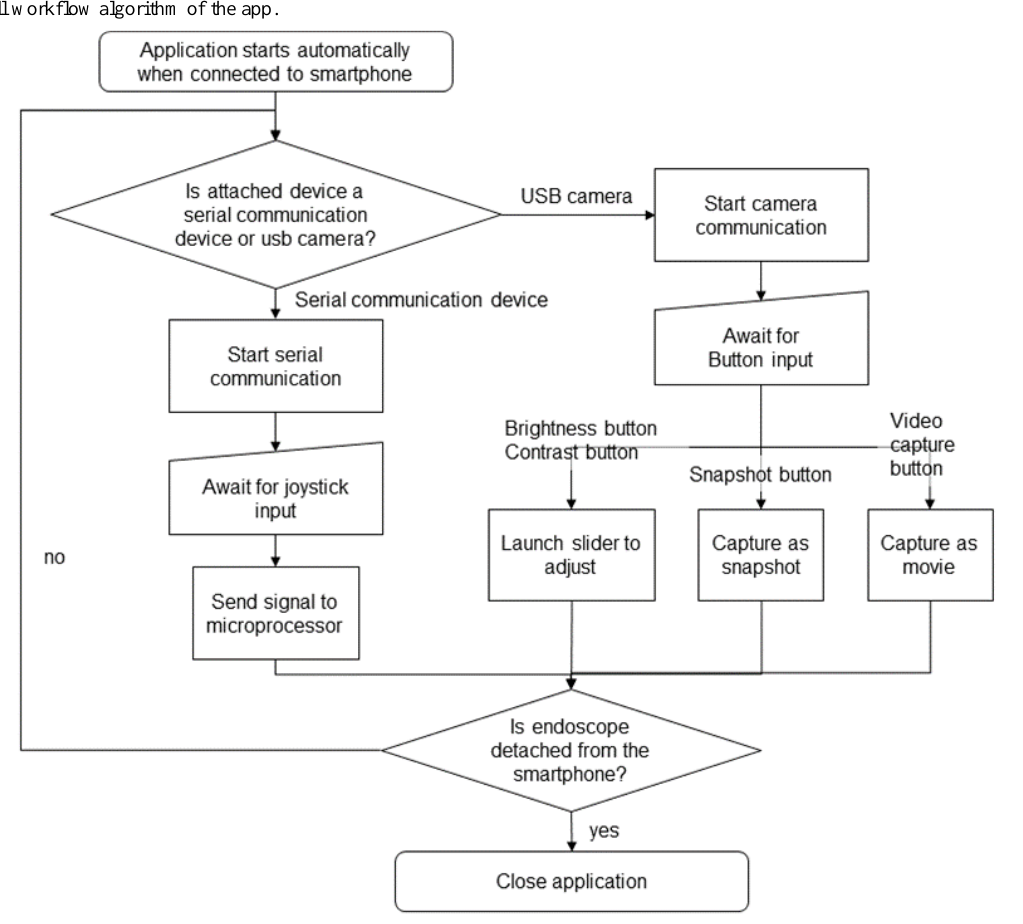
Figure 7. Overall workflow algorithm of the